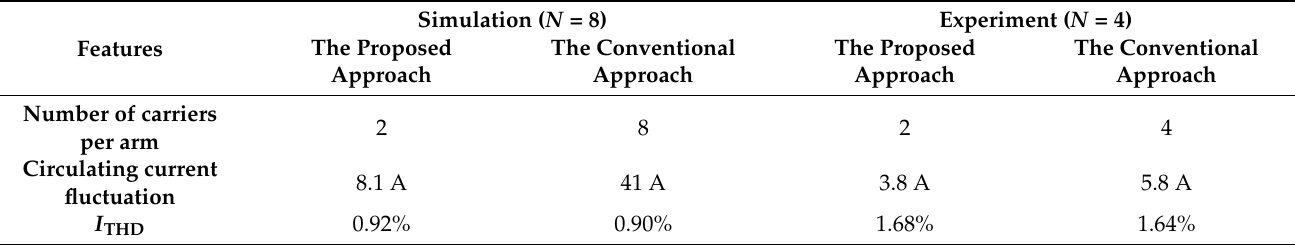
Figure 25. The total harmonic distortion of the output current at cos φ = 0.623 ( N = 4). ( a ) The proposed modulation approach, ( b ) the conventional modulation approach. Table 4. Features of the different approaches at cos φ = 0.954.